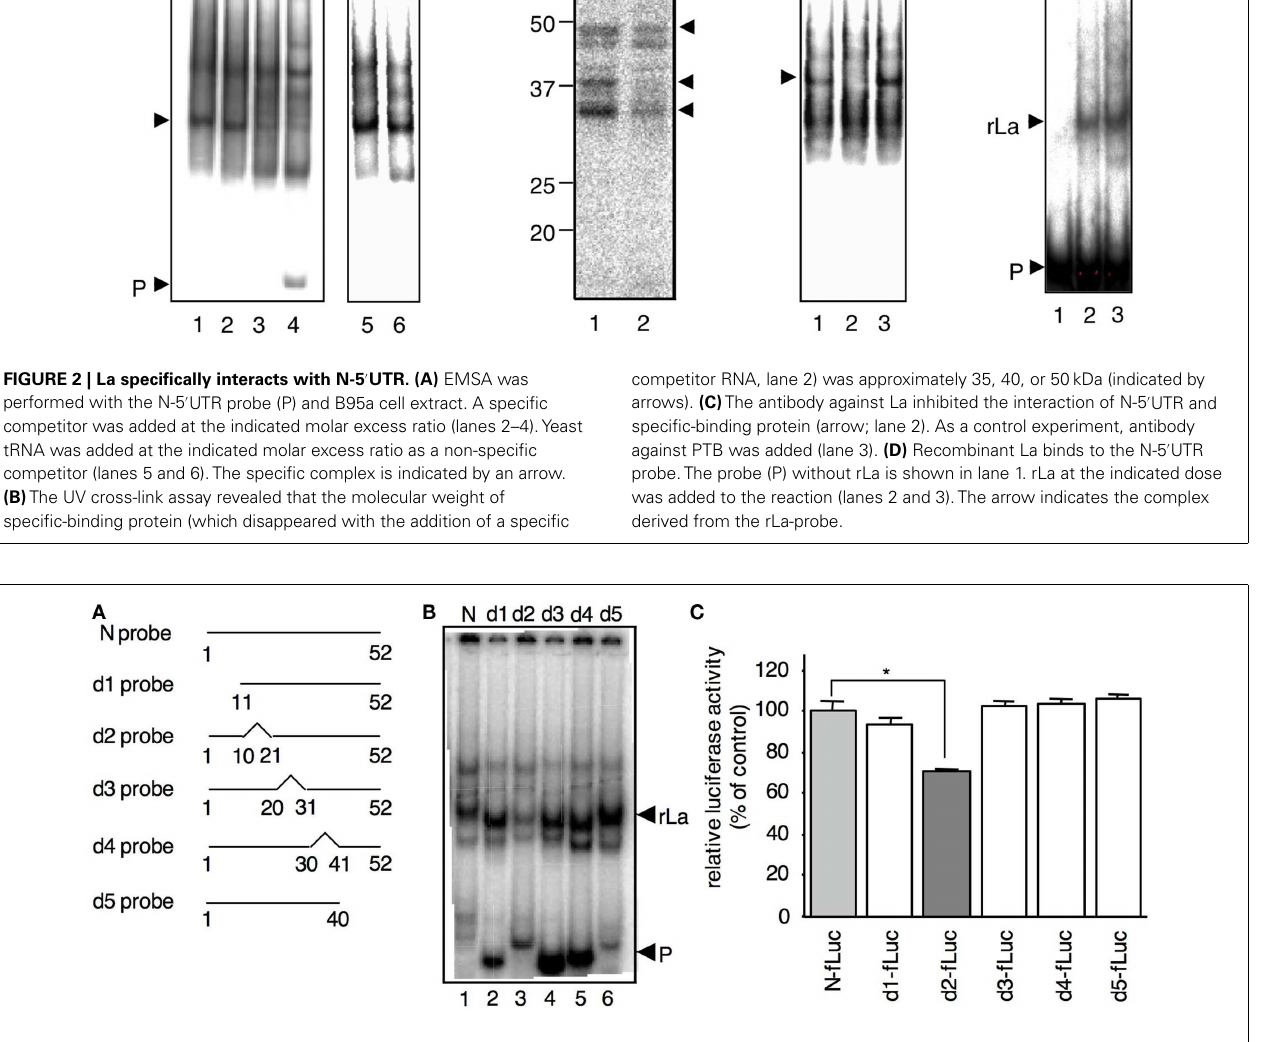
FIGURE 3 |The interaction of La with N-5 (cid:2) UTR requires a specific nt sequence in N (nt 11–20). (A) Outline of the deleted N-5 (cid:2) UTR probes used in the EMSA.The broken lines indicate the deleted regions. (B) The binding activity of rLa to the d2 probe was lower than that of other probes.The interactions of rLa with the probes (La) and the free probe (P) are indicated by